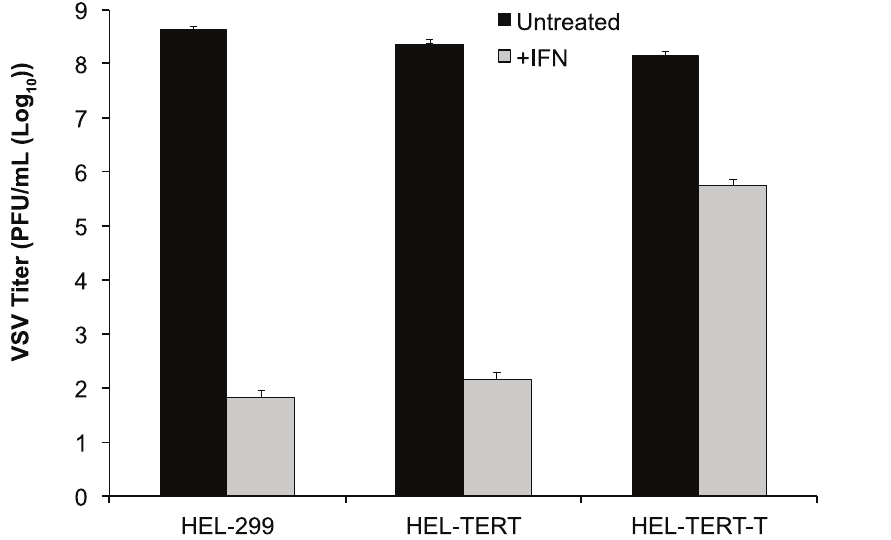
Figure 8. Replication of VSV is diminished by IFN- b in HEL-299 and HEL-TERT but not HEL-TERT-T cells. HEL-299, HEL-TERT, and HEL- TERT-T cells were mock or pre-treated with IFN- b (1000 U/mL) and were infected (16 h post treatment) with VSV-eGFP at an MOI of 0.1 PFU/cell. Samples were harvested 24 h post-infection. Viral titers were determined by plaque assays. An average of three experiments is shown. In all cases, error bars represent the standard errors of the